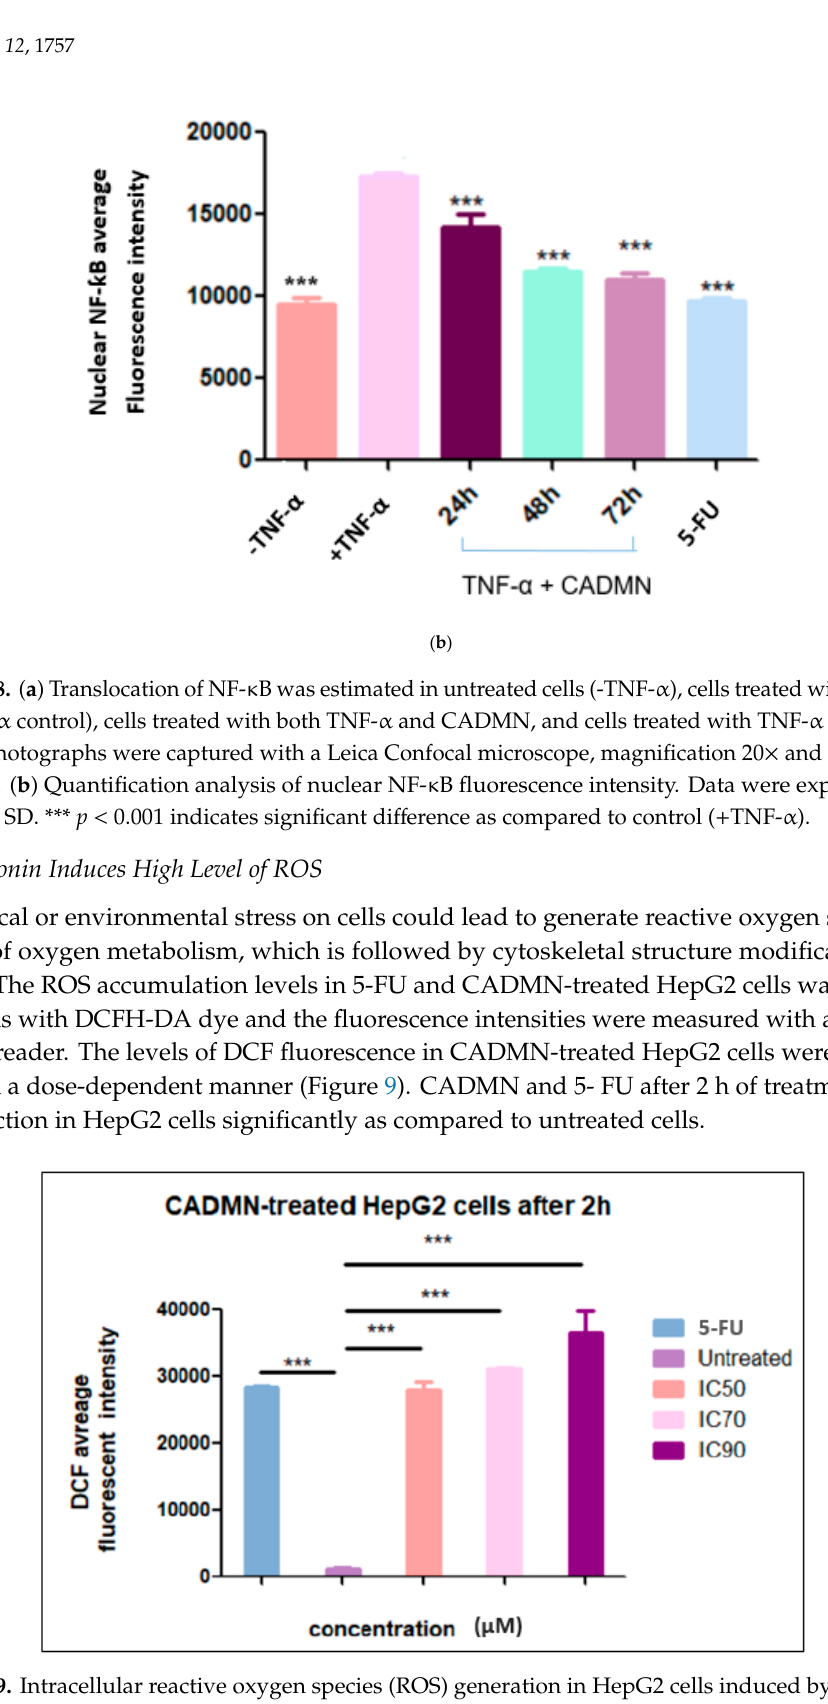
Figure 9. Intracellular reactive oxygen species (ROS) generation in HepG2 cells induced by different concentrations of CADMN (IC 50 , IC 70 and IC 90 ) and 5-FU (IC 50 ). The fluorescence intensities were measured using a fluorescence microplate reader after 2 h of CADMN and 5-FU treatment. Results were expressed as mean ± SD. *** p < 0.001 indicates significantly differences as compared to control untreated cells.